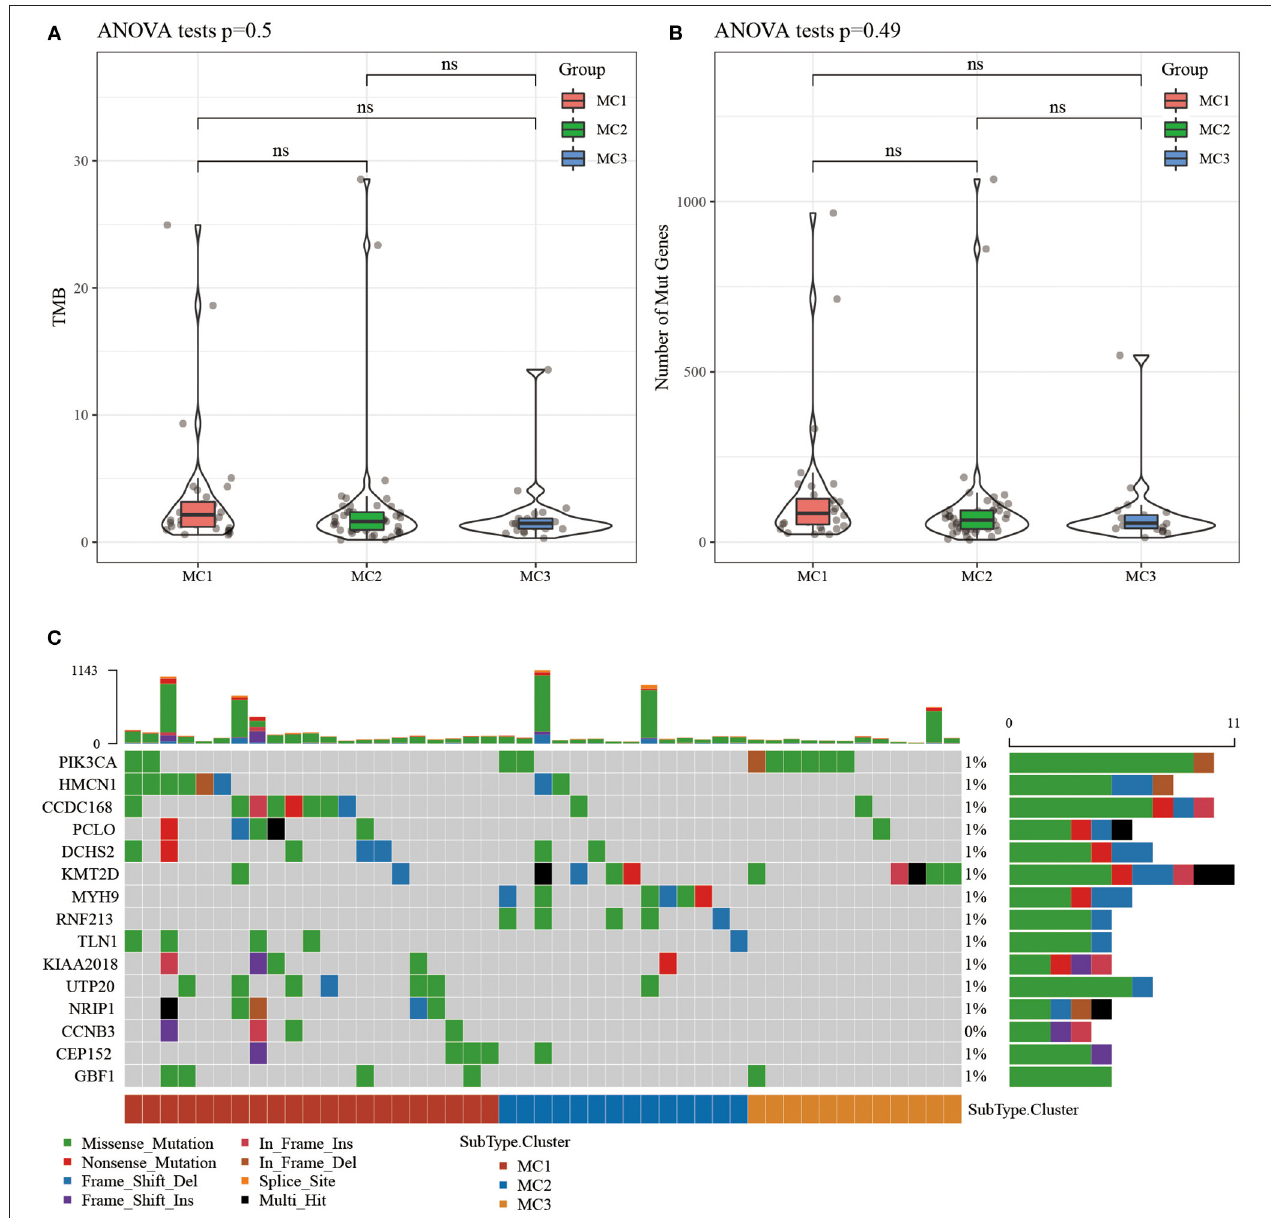
FIGURE 3 | (A) The distribution difference of TMB in the three molecular subtypes of TCGA samples; (B) The distribution difference of the number of gene mutations in the three molecular subtypes of TCGA samples; use the rank sum test to determine the p -value, * p < 0.05; ** p < 0.01; (C) The mutation characteristics of the significantly mutated gene in each subtype sample of TCGA dataset. ns, no